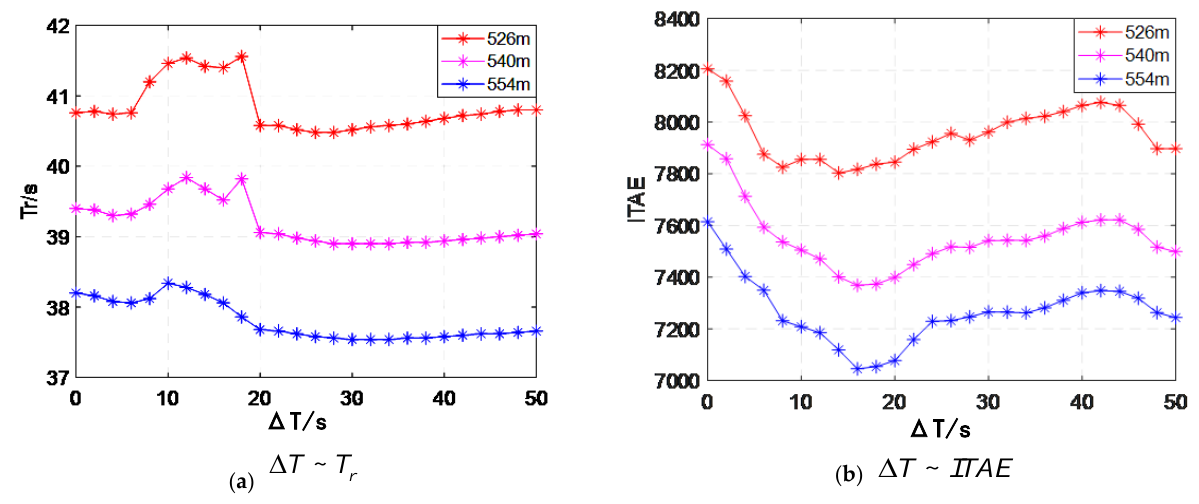
ITAE  r and ITAE of rotational